Question: What kind of plot is shown here?
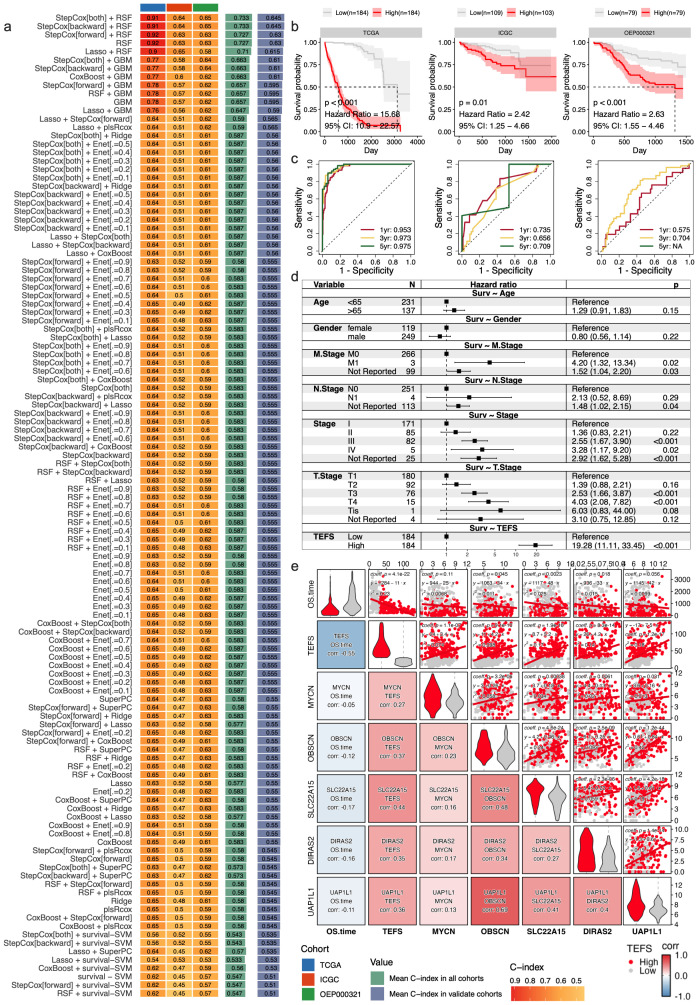
Answer: survival